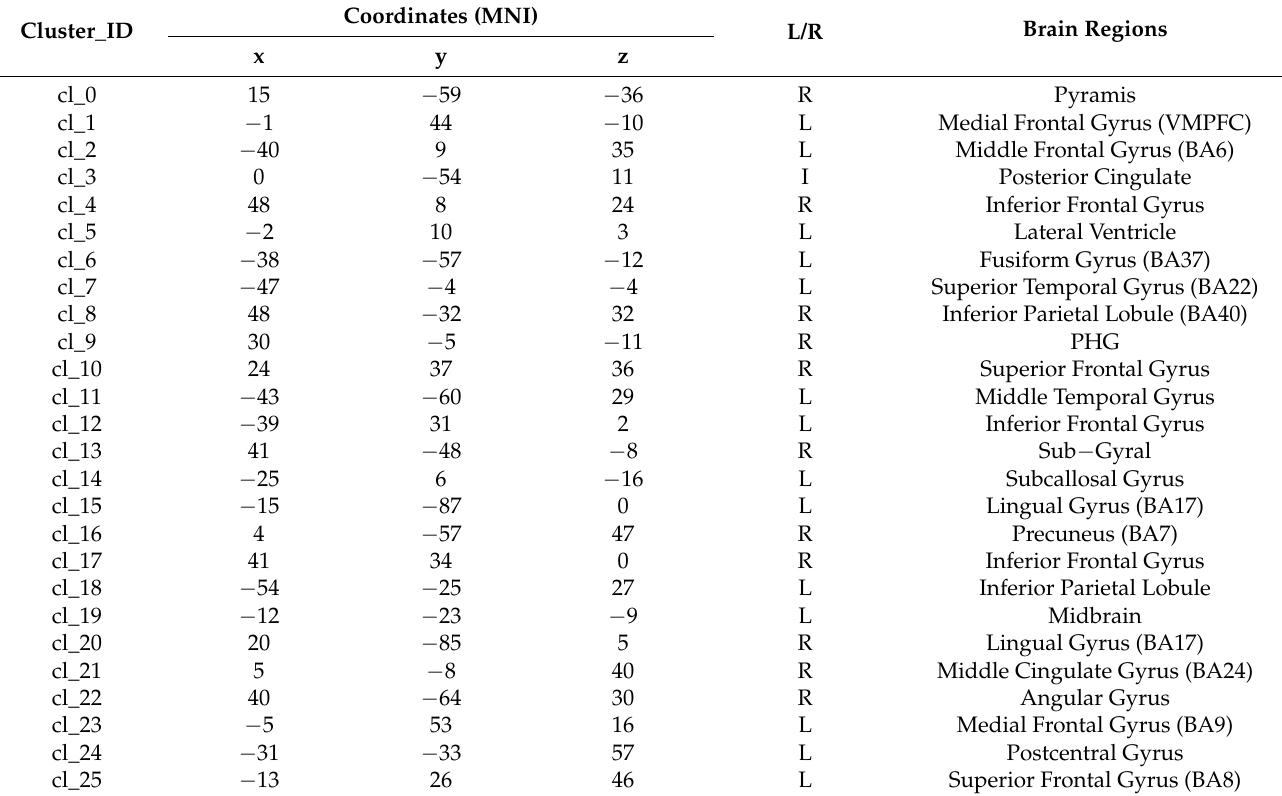
Figure 5. Elbow plot. Table 3. Centroids in each